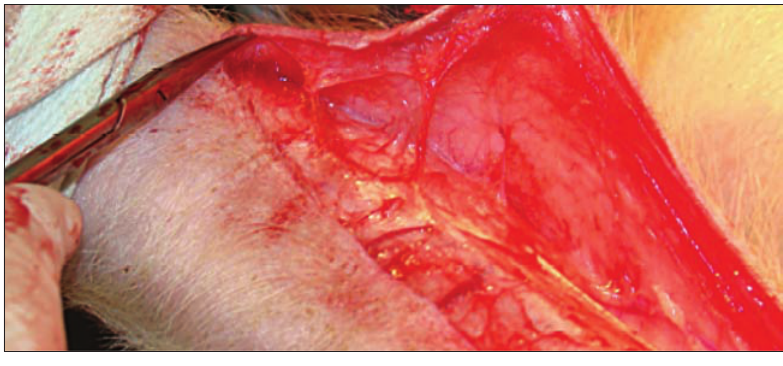
Fig. 4. Perforators identified by micro-dissection